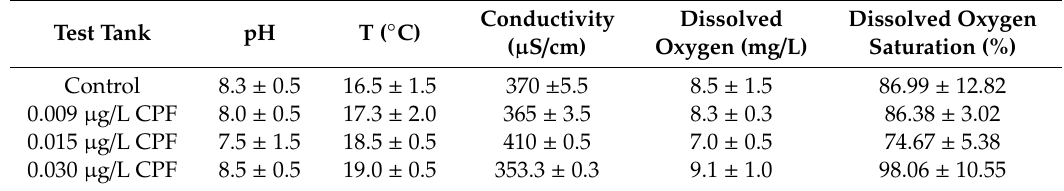
Table 1. Basic water properties measured in three chlorpyrifos (CPF) test tanks and control, according to Yancheva et al.